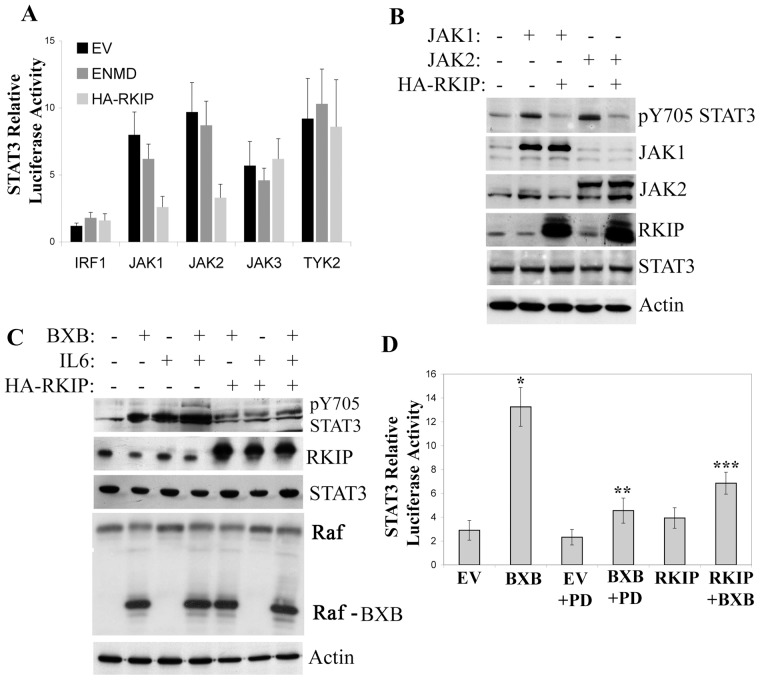
RKIP blocks JAK and Raf-mediated STAT3 activation.(A) RKIP inhibits JAK1, 2-triggered STAT3 activation. 293T cells were transfected with the Luc reporter construct containing 2× STAT3 binding SIE-fragment and co-transfected with either JAK1, 2, 3 or TYK2 in the presence or absence HA-RKIP and ENMD-1198. Cells were placed in serum free medium and cell extracts were subjected to luciferase assay to estimate transcriptional activity. Averages and standard deviations (error bars) of the values of luciferase activities from triplicates of 3 representative experiments are shown. (B) Western blot analysis demonstrating inhibition of STAT3 pY705 phosphorylation in HA-RKIP and JAK1 or 2 transiently transfected 293T cells. Raf-mediated STAT3 pY705 phosphorylation is inhibited by RKIP: (C) 293T cells were transfected with Raf-BXB, CMV empty vector or HA-RKIP. After 48 h cells were left untreated or exposed to IL-6 for 1 h. Cell lysates were analyzed by Western blot. (D) 293T cells were transfected with the STAT3 luciferase reporter construct and/or with EV, Raf-BXB or HA-RKIP. After 24 h, some cells were treated with PD98059 (PD) and after 48 h from the initial time of transfection, some cells were treated with IL-6 for 6 h. A paired t-test was performed indicating *(p<0.000005) increase in BXB transfected cells when compared to EV; decrease in STAT3 transcriptional activity **(p<0.00006) in PD treated cells transfected with BXB and ***(p<0.00004) in RKIP and BXB transfected cells when compared to the cells transfected with BXB. Luciferase reporter activities for triplicates of 3 representative experiments +/- s.d. are shown. Western blot analysis of cells transfected with the indicated proteins in the presence or absence of PD treatment.